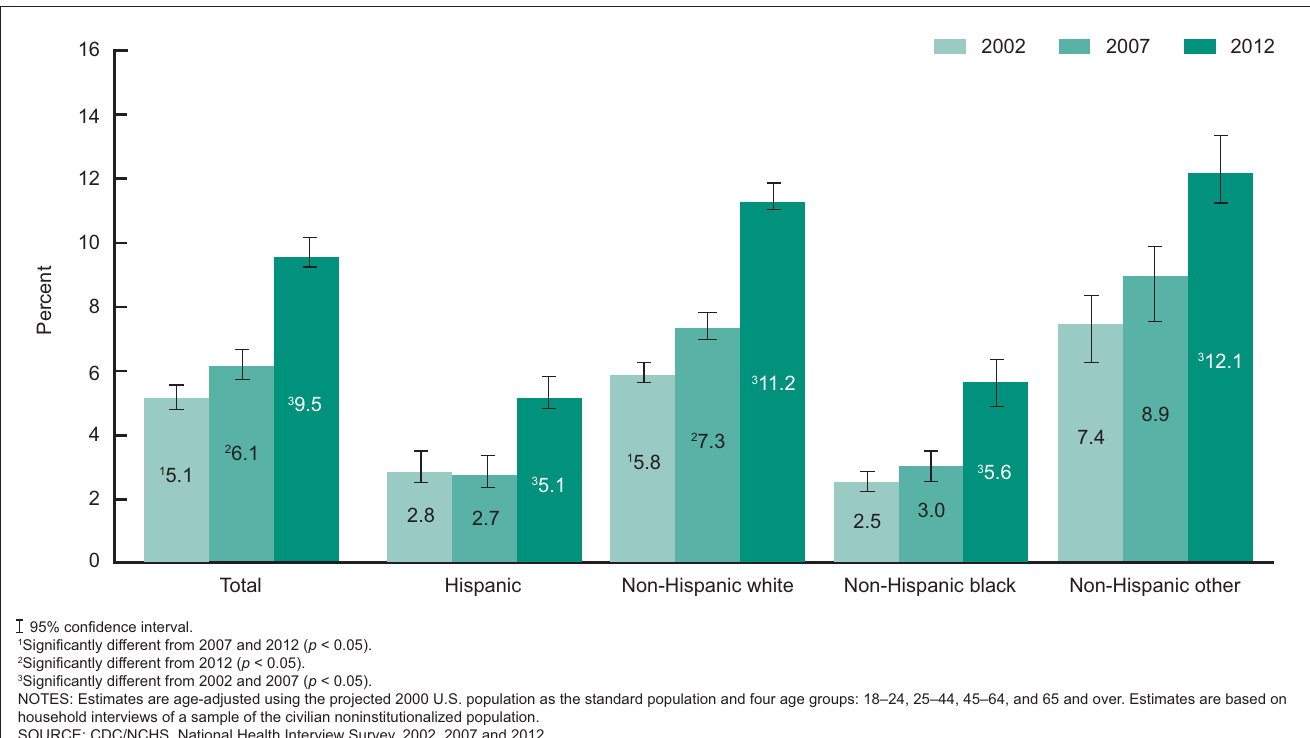
Figure 3. Use of yoga among adults in the past 12 months, by Hispanic origin and race: United States, 2002, 2007, and 2012